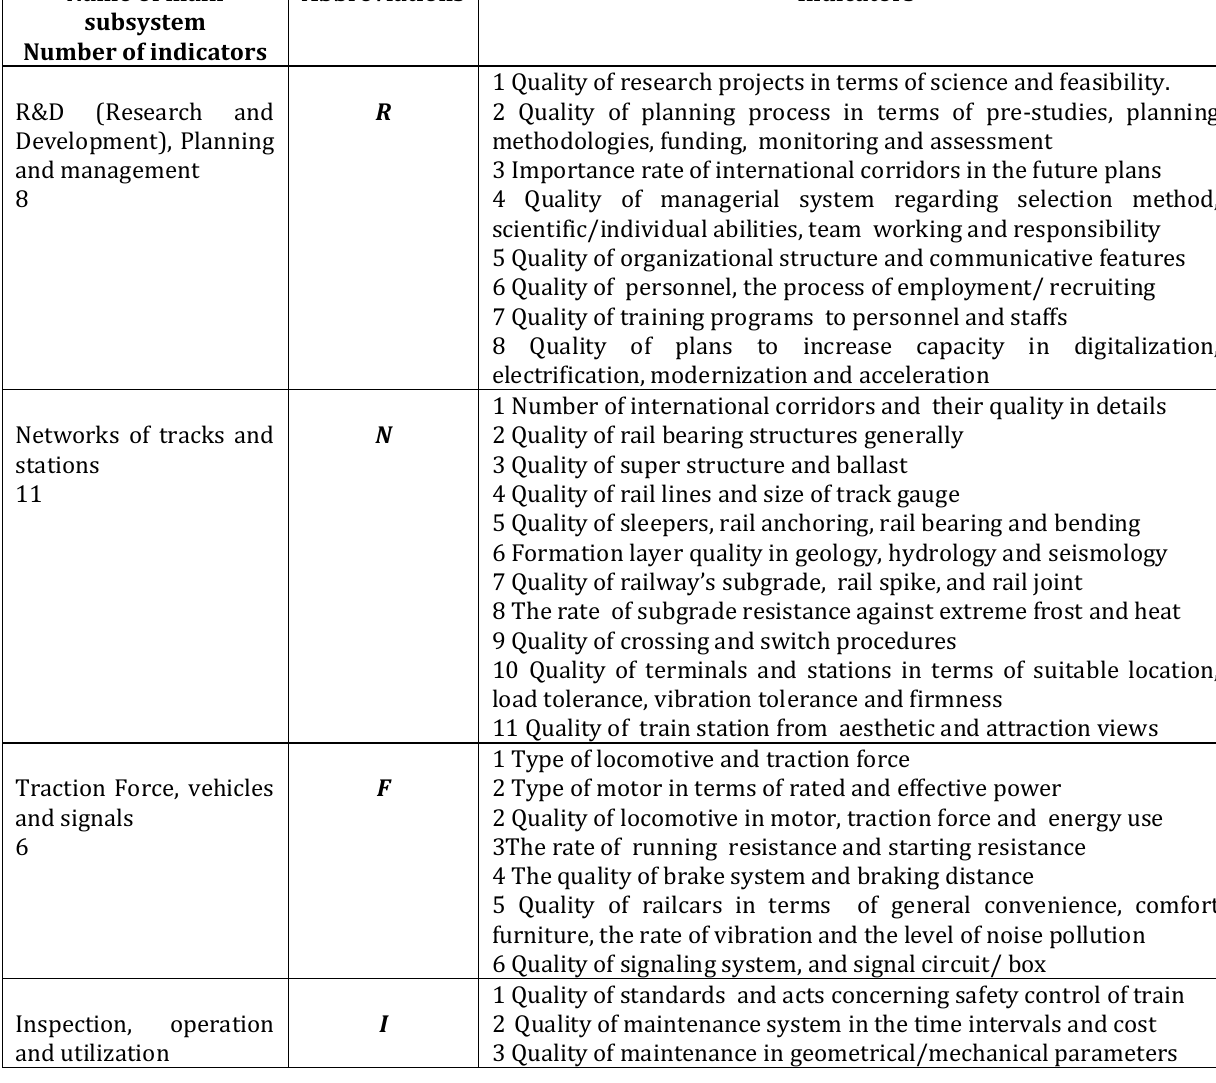
Table 1: Major subsystems with 40 indicators to assess the quality of the railroad industry in Iran Name of